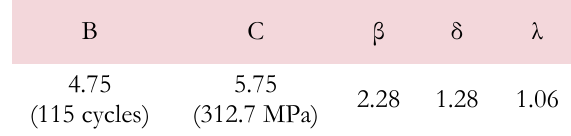
Table 2: Weibull model parameters from fitting of the S-N field.